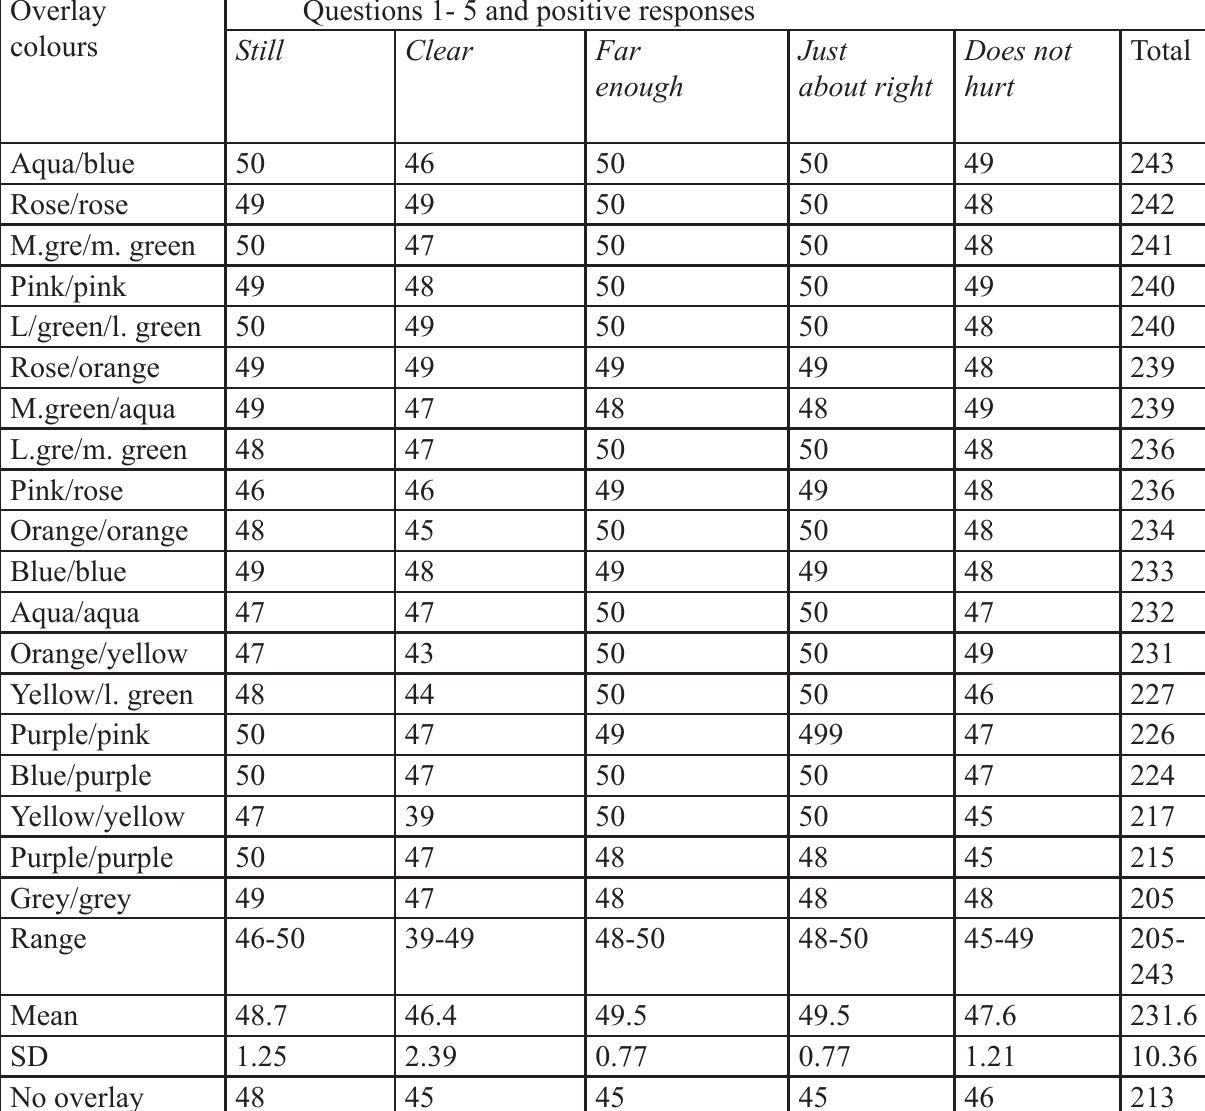
Table 3. Showing the Wilkins 18 questions 1-5 and the positive responses with double overlays for all subjects (N= 50). Aqua/blue overlay provided the highest number of positive responses and grey/grey provided the least number of positive responses. The high - est score per question would be 50 and 250 for the five questions in this forced-choice